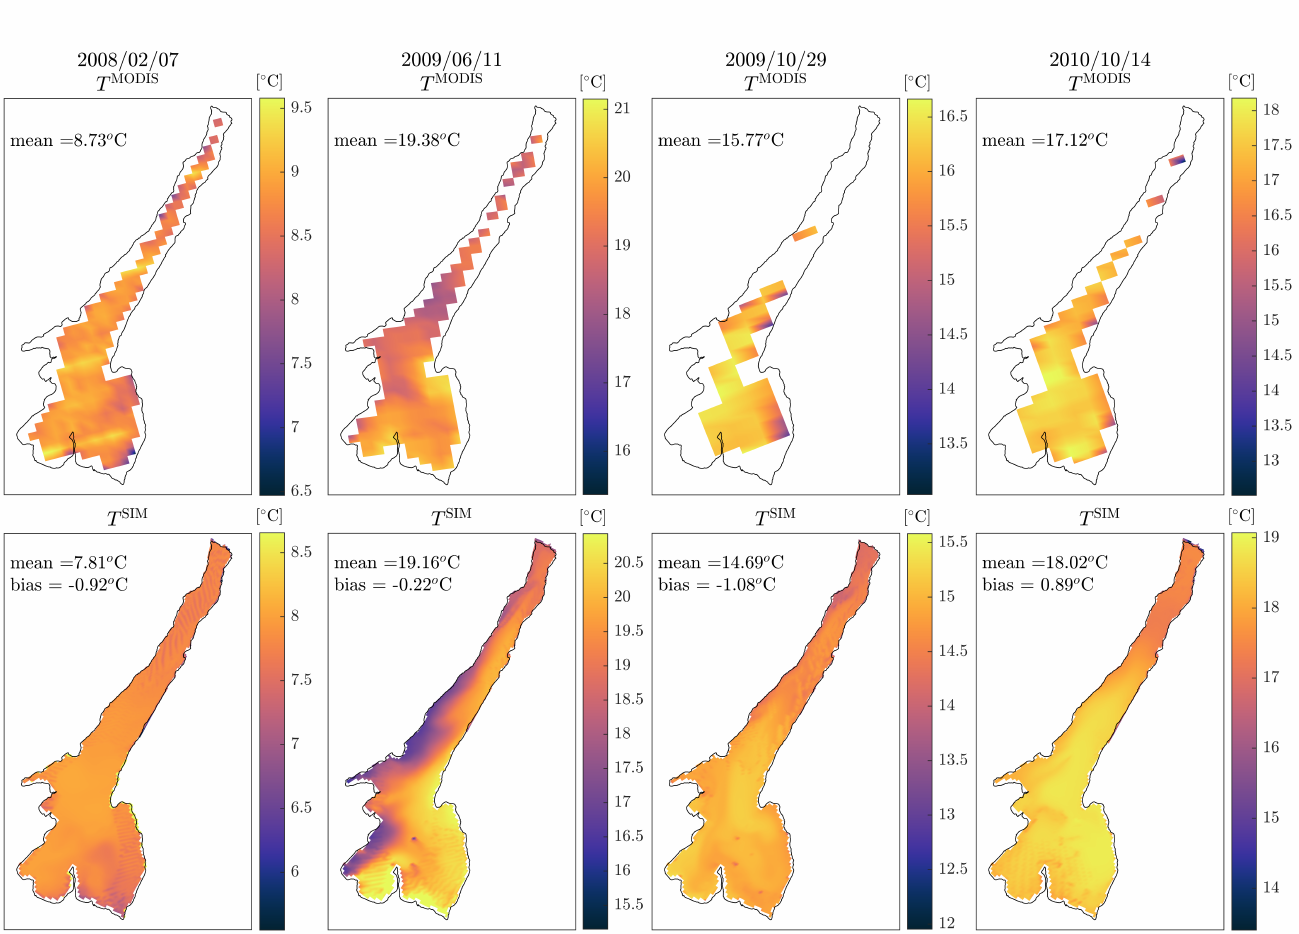
Figure 3. Top plots: maps of SST from MODIS Terra on cloud-free investigated dates. Bottom plots: maps of simulated lake surface water temperature. The spatial mean of MODIS and simulated water temperature is displayed together with the existing bias ( T SIM − T MODIS ). Note: in each panel, colorbar limits are set differently to highlight the spatial patterns. The colorbar limits of bottom plots are set as those from top plots at the corresponding date + the computed